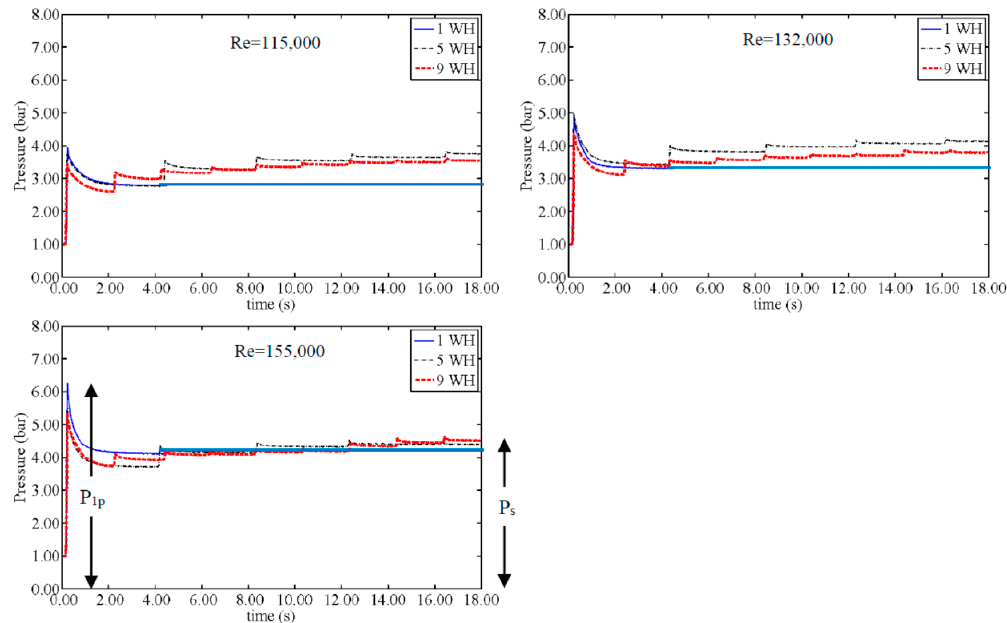
Figure 2. Pressure change in the air pocket (AP) for different water hammer (WH) events and Reynolds number (Re) for the volume fraction ratio VFR = 4.75%.